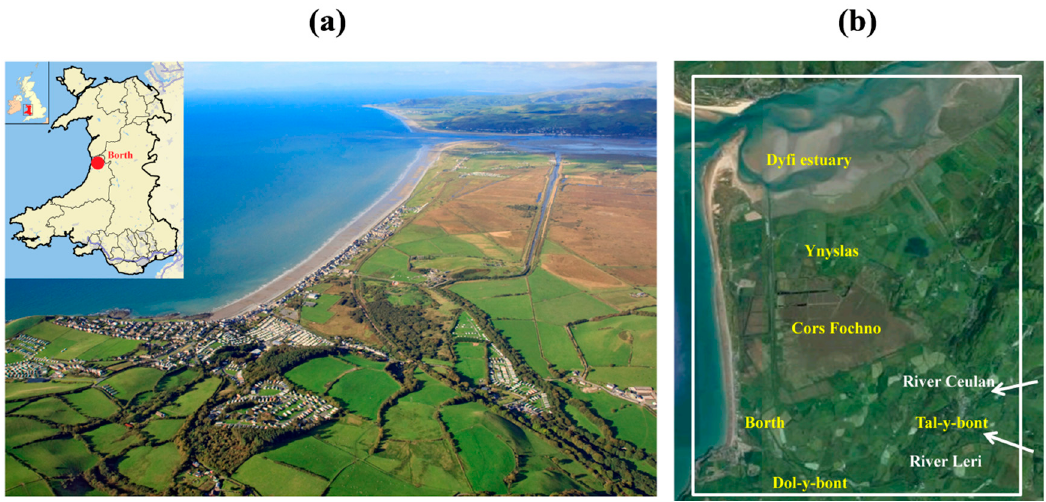
Figure 2. The village of Borth ( a ) (Retrieved from http://www.janetbaxterphotography.co.uk), and the Borth study domain ( b ) (adopted from Google Maps).